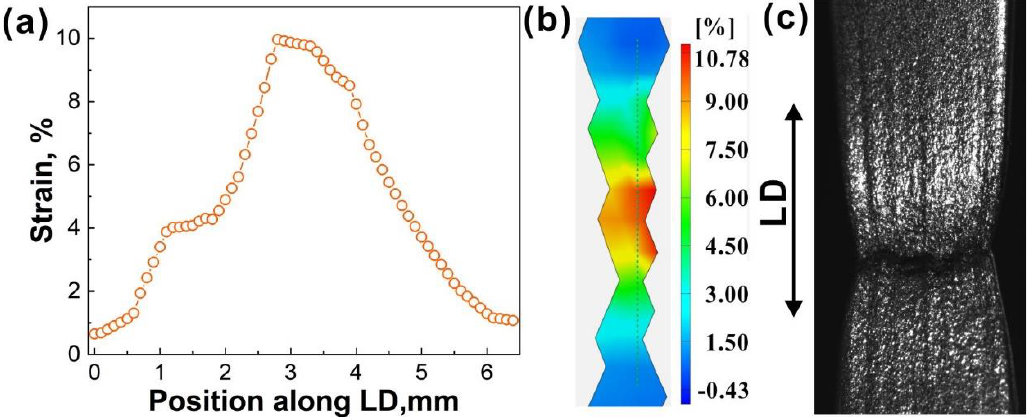
Figure 6. Deformation localization: ( a ) the strain along the loading direction, ( b ) strain nephogram, and ( c ) specimen after fracture.